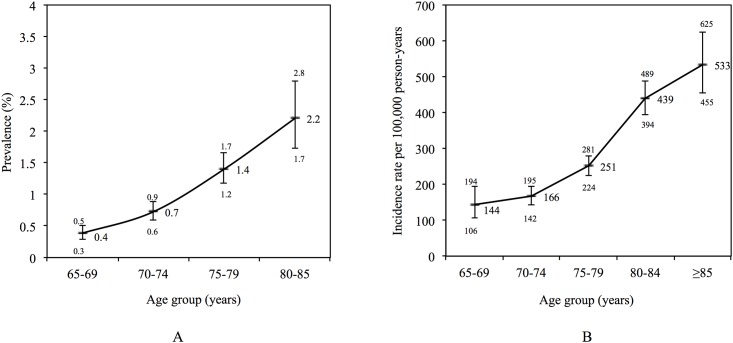
Panel A: the diamonds depict the percentage prevalence of Parkinson’s disease for each age group and the whiskers the 95% confidence interval of the prevalence estimate. Panel B: the diamonds depict the incidence rate of Parkinson’s disease by age group per 100,000 person-years, and the whiskers the 95% confidence interval of the rates.